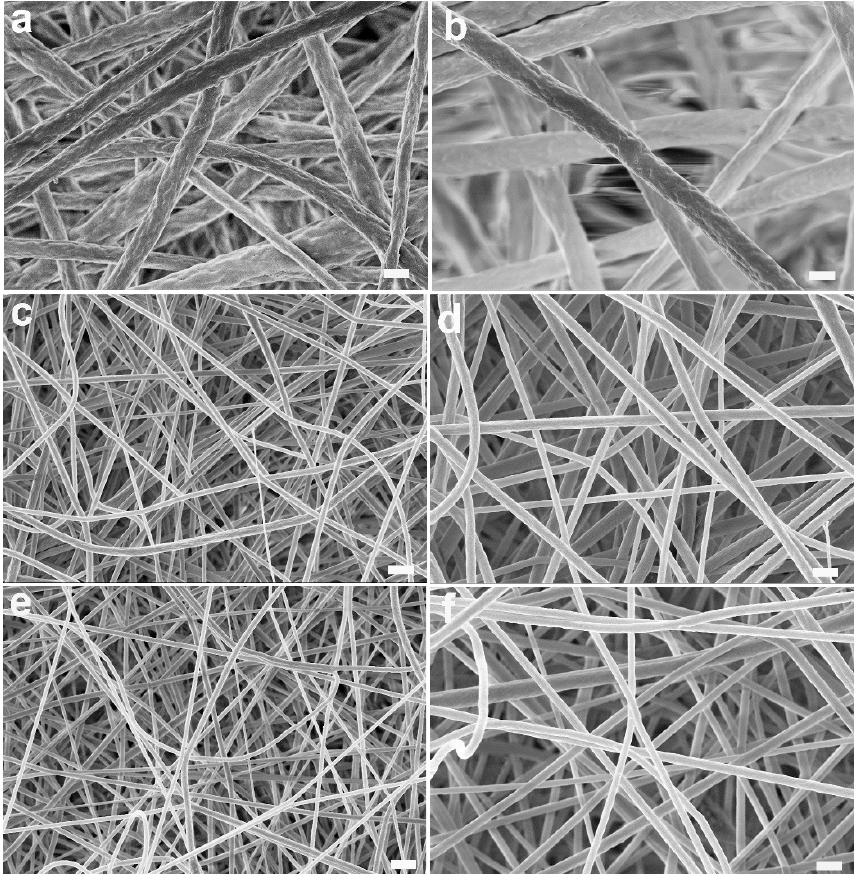
Figure 2. Representative SEM images of electrospun samples: PVDF ( a , b ), PVDF/PCADE 85/15 ( c , d ) and PVDF/PCADE 70/30 ( e , f ). Scale bar: 2 μm ( a , c , e ) and 1 μm ( b , d , f ).